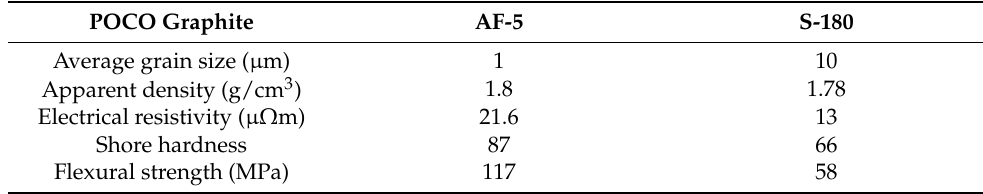
Figure 1. Graphite microstructure at ×5000 magnification for the samples: ( a ) AF-5; ( b ) S-180. Table 2. Physical properties of POCO graphite electrodes.